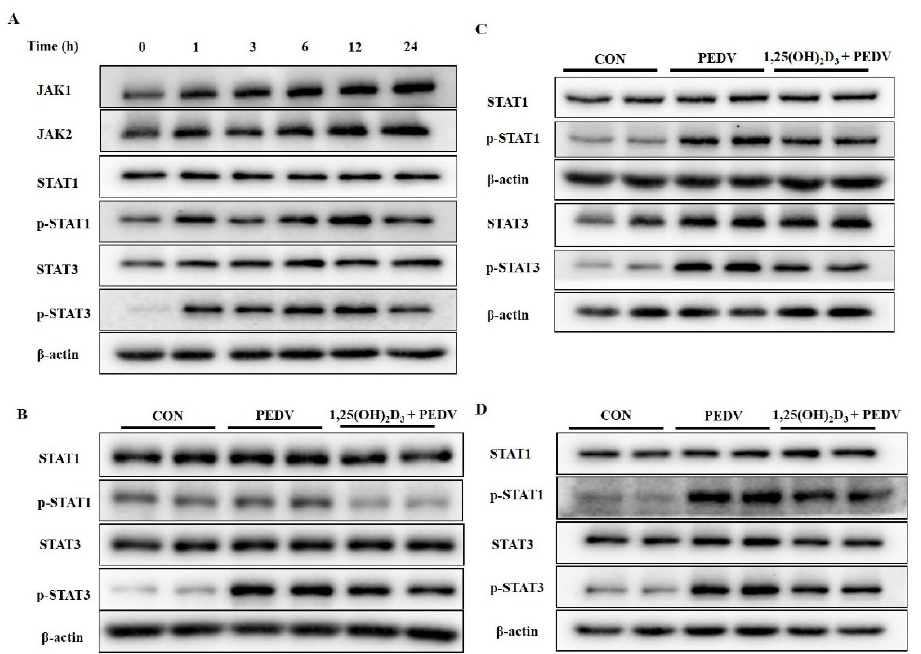
Figure 5. Effects of 1,25(OH) 2 D 3 supplementation on JAK/STAT signaling pathway in PEDV-infected-IPEC-J2 and 3D4/21 cells. IPEC-J2 cells were infected with PEDV at MOI of 1. After 1 h of absorption, the cells were washed with PBS and then cultured with fresh culture medium for different times. Then, the cells were collected for Western blotting analysis ( A ). IPEC-J2 cells were pretreated with 1,25(OH) 2 D 3 (20 nM) for 24 h, and then infected with PEDV at MOI of 1. After 1 h of absorption, the cells were washed with PBS and then cultured with 1,25(OH) 2 D 3 (20 nM) for 1 h ( B ) or 24 h in IPEC-J2 ( C ) and 3D4/21 cells ( D ). Finally, the cells were collected for Western blotting analysis.